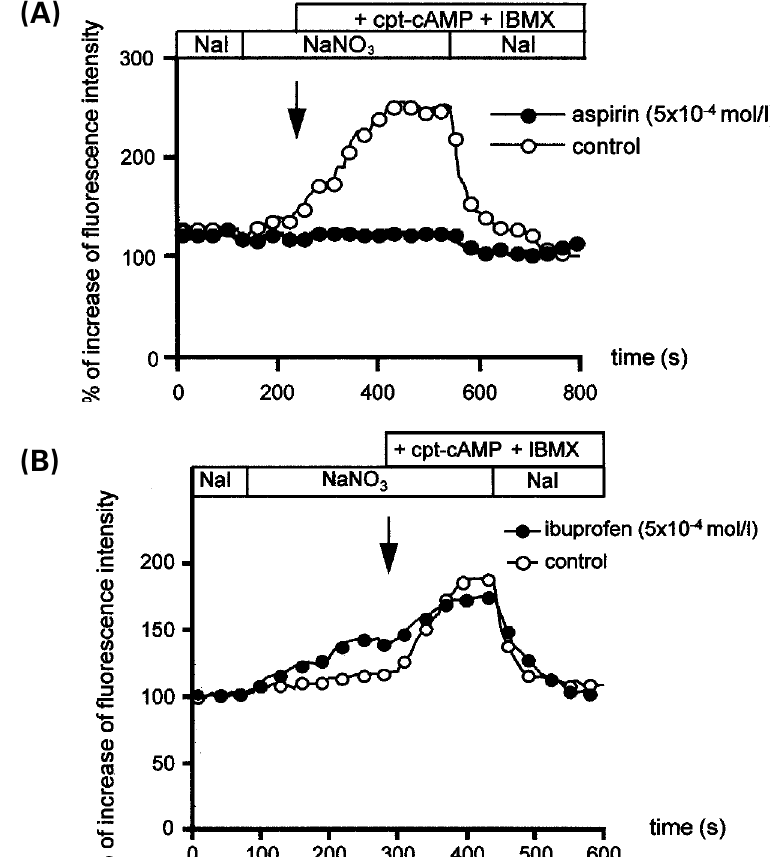
FIG. 7. The fluorescence of intracellular MEQ was measured with respect to time under control conditions and after 48h of treatment with either 5 3 10 –4 mol/l aspirin (A) or 5 3 10 –4 mol/l ibuprofen (B). The sequence of buffer substitutions is indicated in the